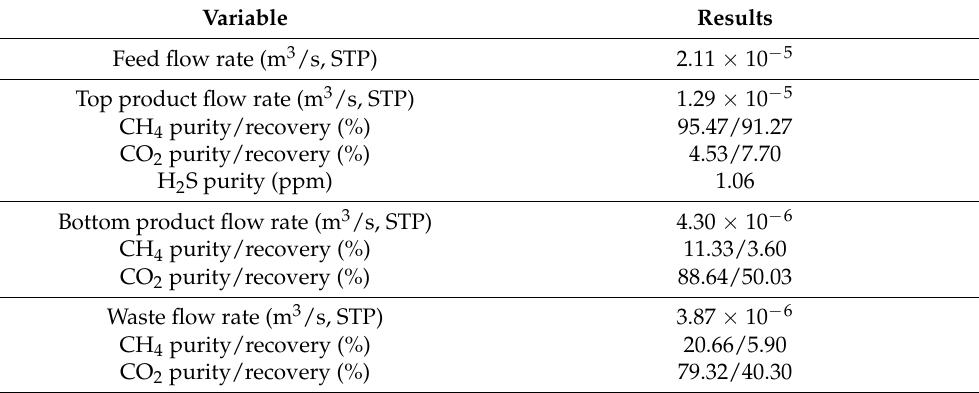
Table 13. Simulation results of the basic case PSA